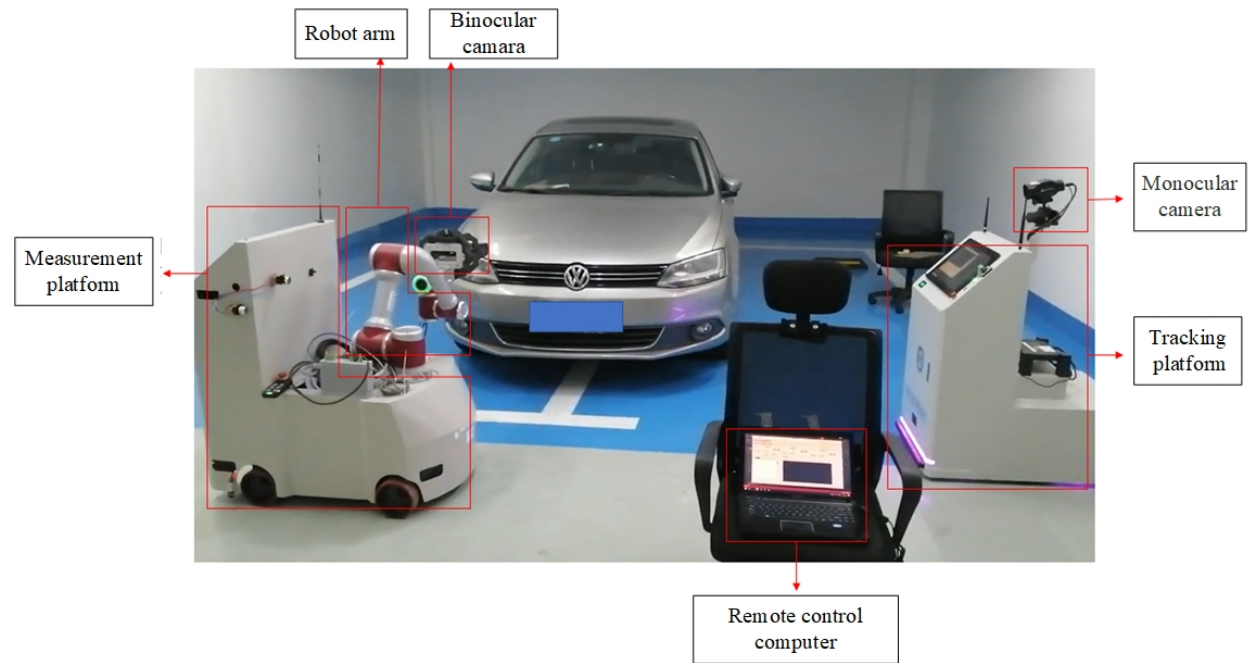
Figure 18. Establishment of the experimental platform for data acquisition of the vehicle